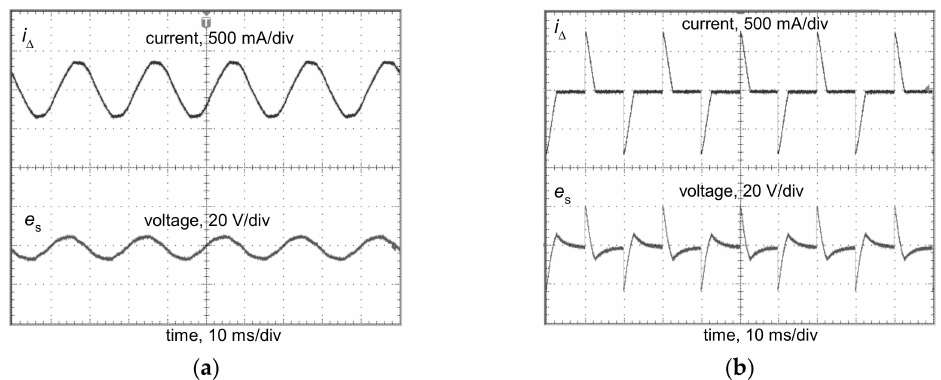
Figure 21. Oscillograms of the induced secondary voltage e s in the secondary winding of the current sensor from a 300 mA A-type RCD, for the following current delay angles of the residual current: ( a ) 0 ◦ ; ( b ) 135 ◦ ; in both cases, the rms values of the residual current i ∆ are the